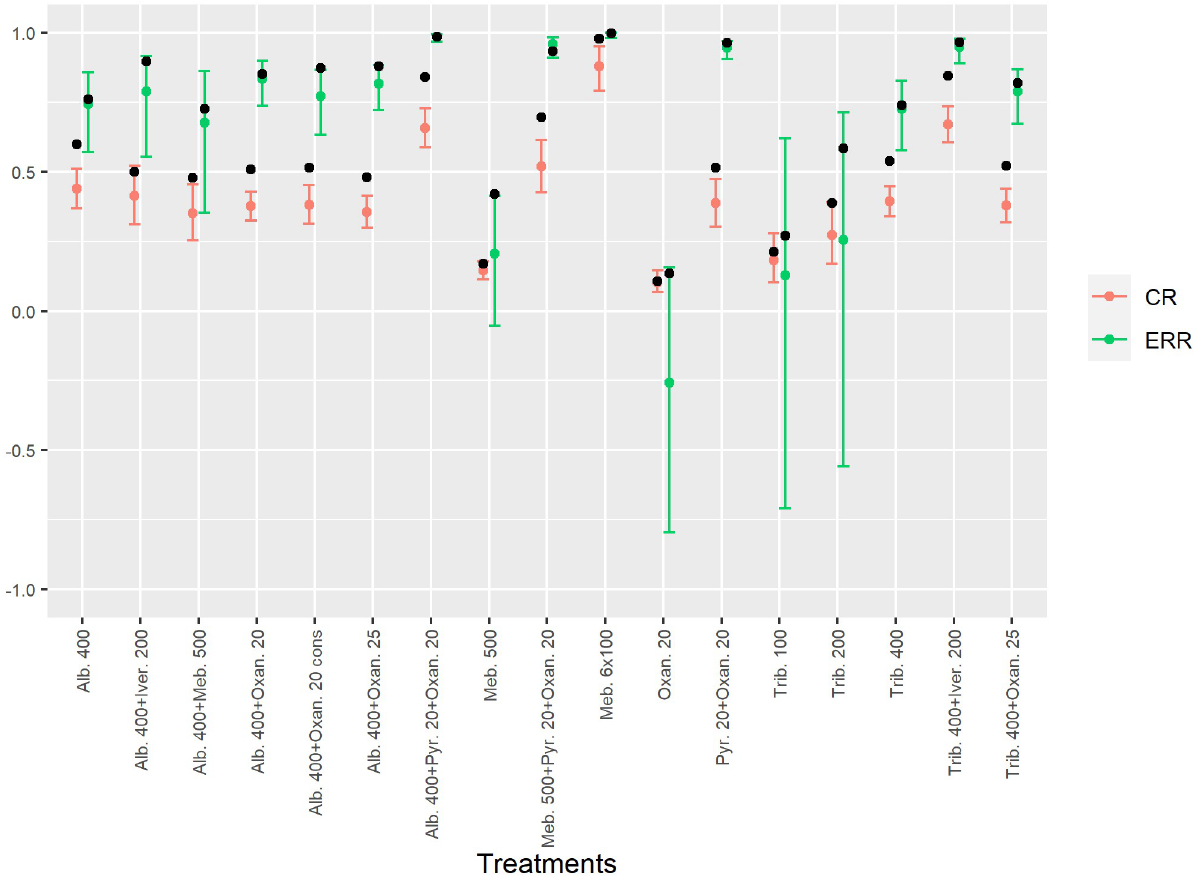
Fig 2. Estimated and observed cure rates (CRs) and egg reduction rates (ERRs). Posterior mean and 95% Bayesian credible interval of the CR and the ERR (arithmetic mean) for the different treatment arms for hookworm. The black dots show the observed